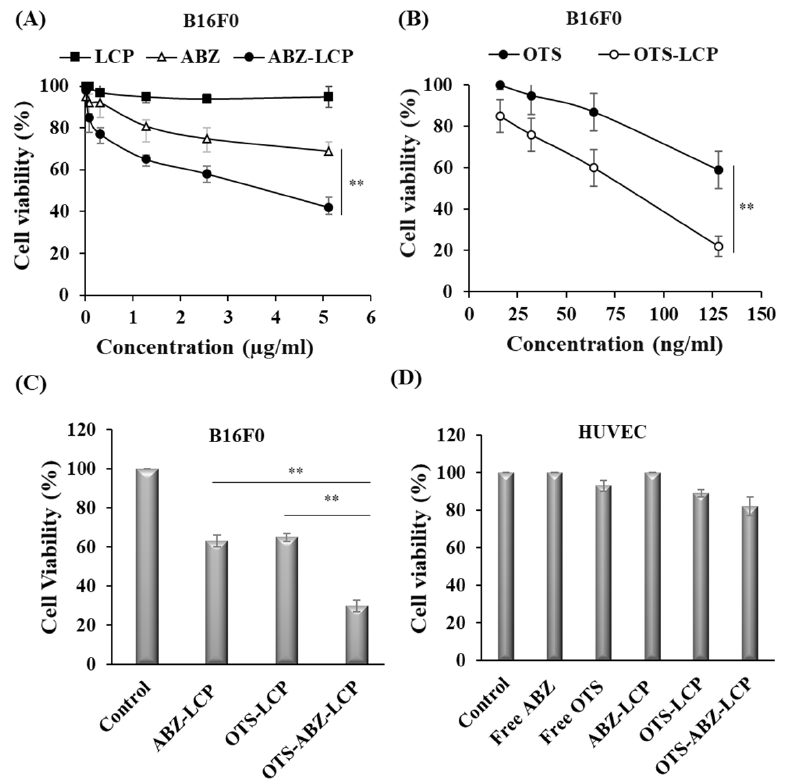
Figure 2. Evaluating the cytotoxicity of LCP-based nanoparticles on B16F0 and HUVEC Cells. ( A ) Inhibition of B16F0 cells treated for 24 h with ABZ-LCP; ( B ) OTS-LCP; and ( C ) OTS-ABZ-LCP (ABZ: 2.5 µ g/mL and OTS: 64 ng/mL). ( D ) Viability of HUVEC cells treated with ABZ-LCP, OTS-LCP and OTS-ABZ-LCP for 72 h (ABZ: 5 µ g/mL and OTS: 128 ng/mL). Data are presented as mean ± SEM (n = 3–5).